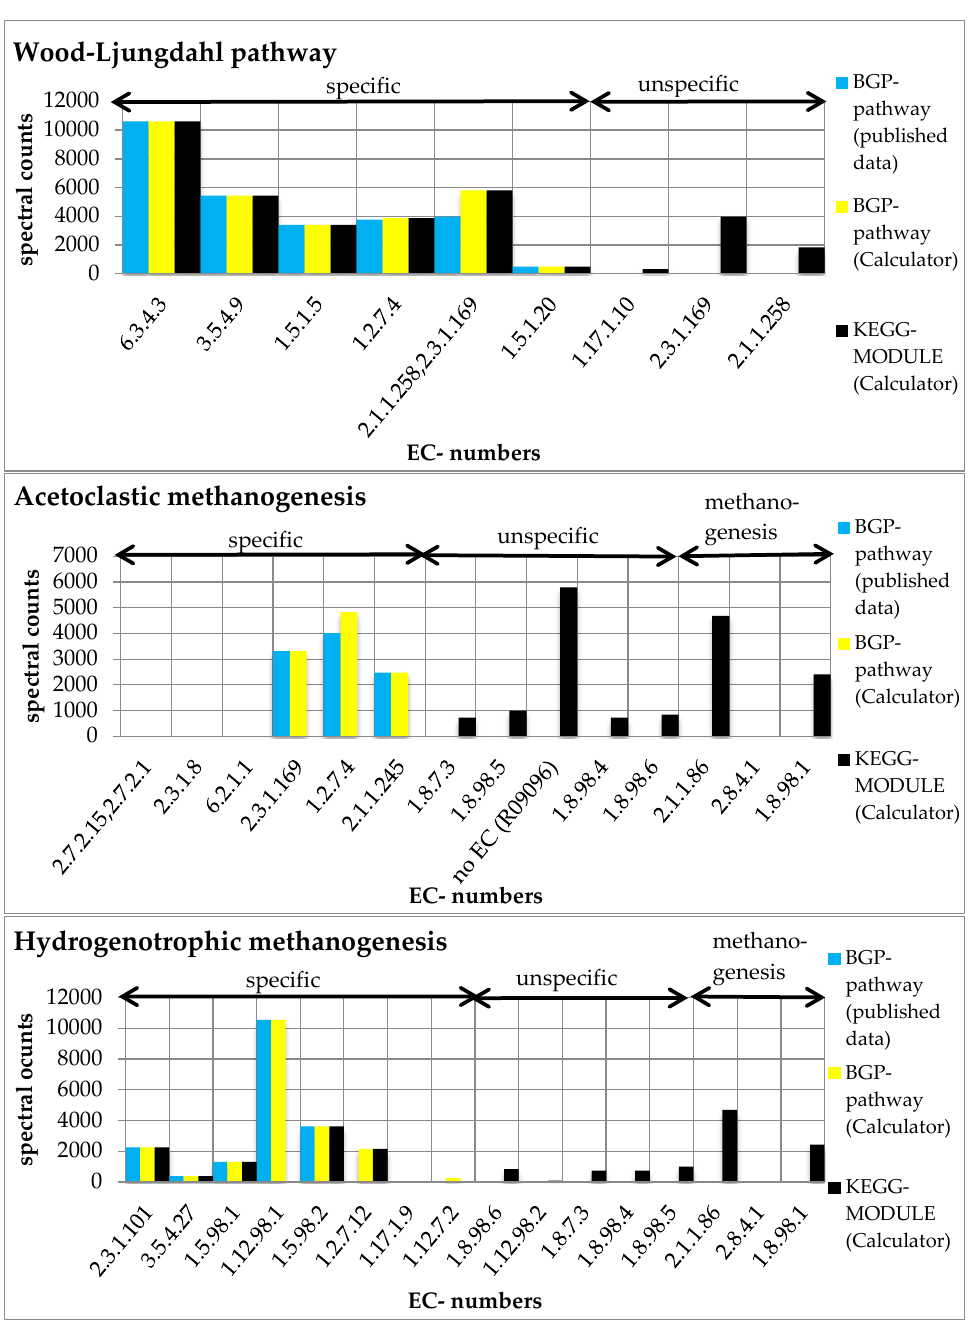
Figure 4. Summed spectral counts of each reaction in the Wood–Ljungdahl pathway, acetoclastic methanogenesis, and hydrogenotrophic methanogenesis. Results from published data [8] are visualized in blue, results from the ‘Pathway-Calculator’ that are user-defined are shown in yellow, and results from the ‘Pathway-Calculator’ for KEGG MODULEs are shown in black. All KEGG MODULEs possess additional unspecific reactions. KEGG-acetoclastic methanogenesis and KEGG-hydrogenotrophic methanogenesis possess three additional reactions (2.1.1.86, 2.8.4.1., and 1.8.98.1) that catalyze the last steps of the methanogenesis (see Supplementary File S19).